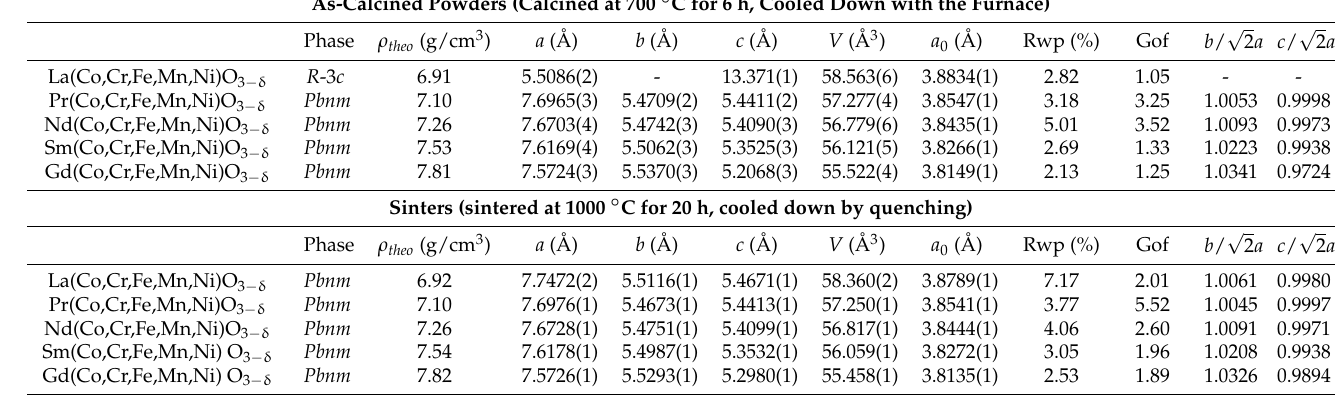
Table 1. The results of the Rietveld refinement with the procedure’s residuals for the Ln(Co,Cr,Fe,Mn,Ni)O 3 − δ (Ln = La, Pr, Nd, Sm, Gd)